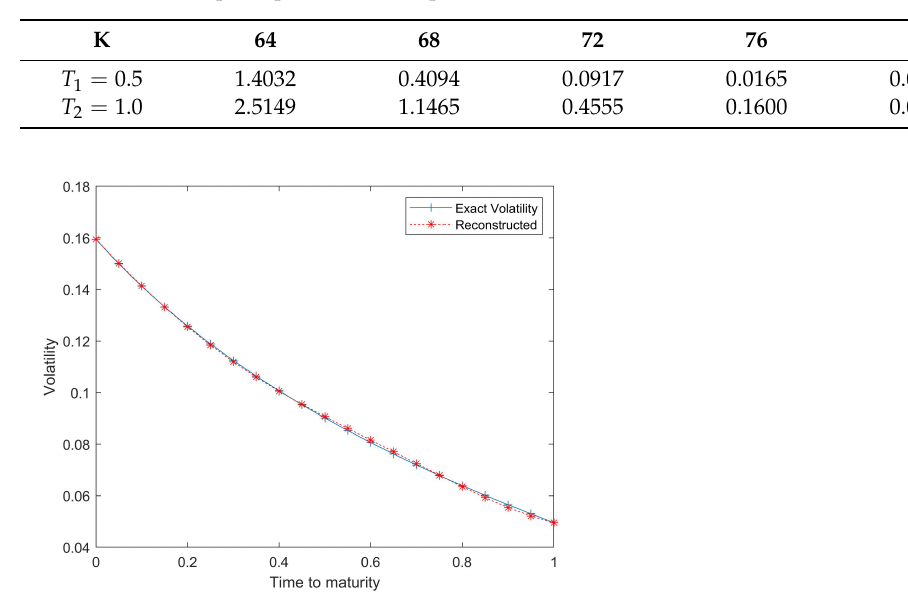
Figure 1. Comparison between the recovered and exact volatility for Example